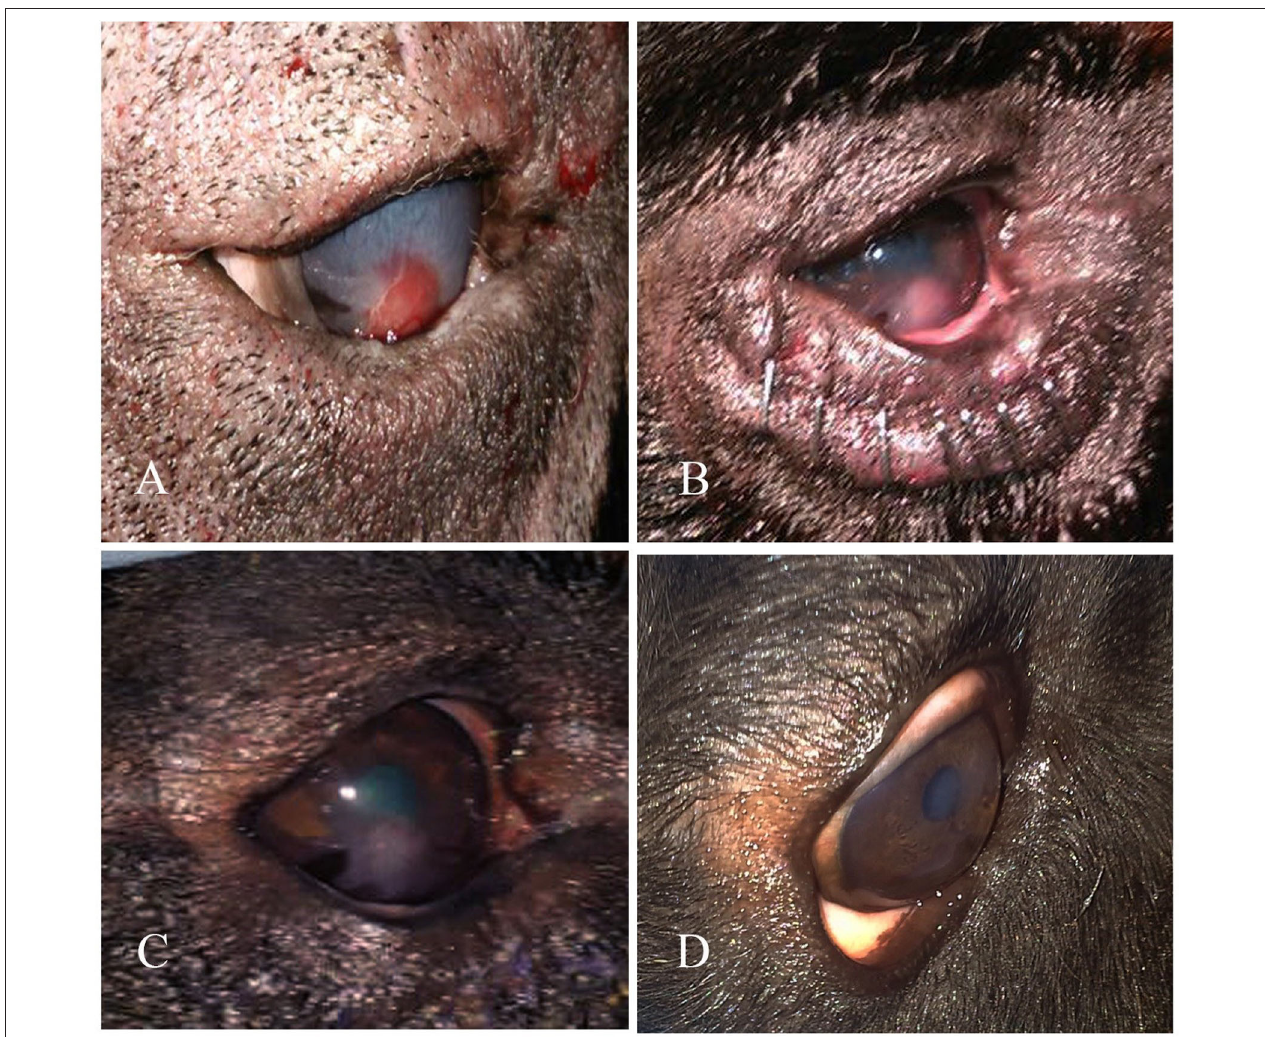
FIGURE 3 | A photography series of Rottweiler dog showing (A) entropion with corneal ulcer (B) post-operative after surgical correction of entropion and injection of PRP (C) reduction of corneal ulcer size after 1-week post-injection (D) complete healing of ulcer after 2 weeks of